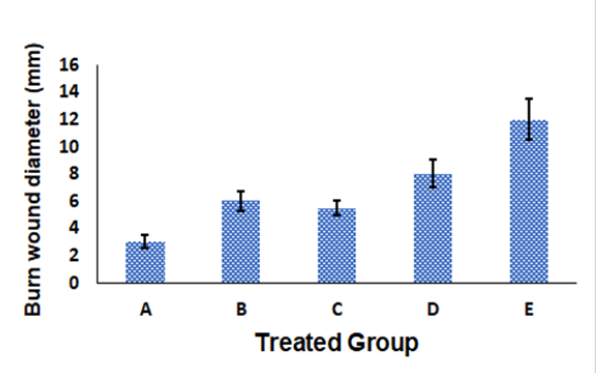
Figure 4. Mean burn wound diameter for different formulations: optimum Gr-PV-NE ( A ), Gr-NE ( B ), PV-NE ( C ), PV-Gr mixture ( D ), and normal saline ( E ).